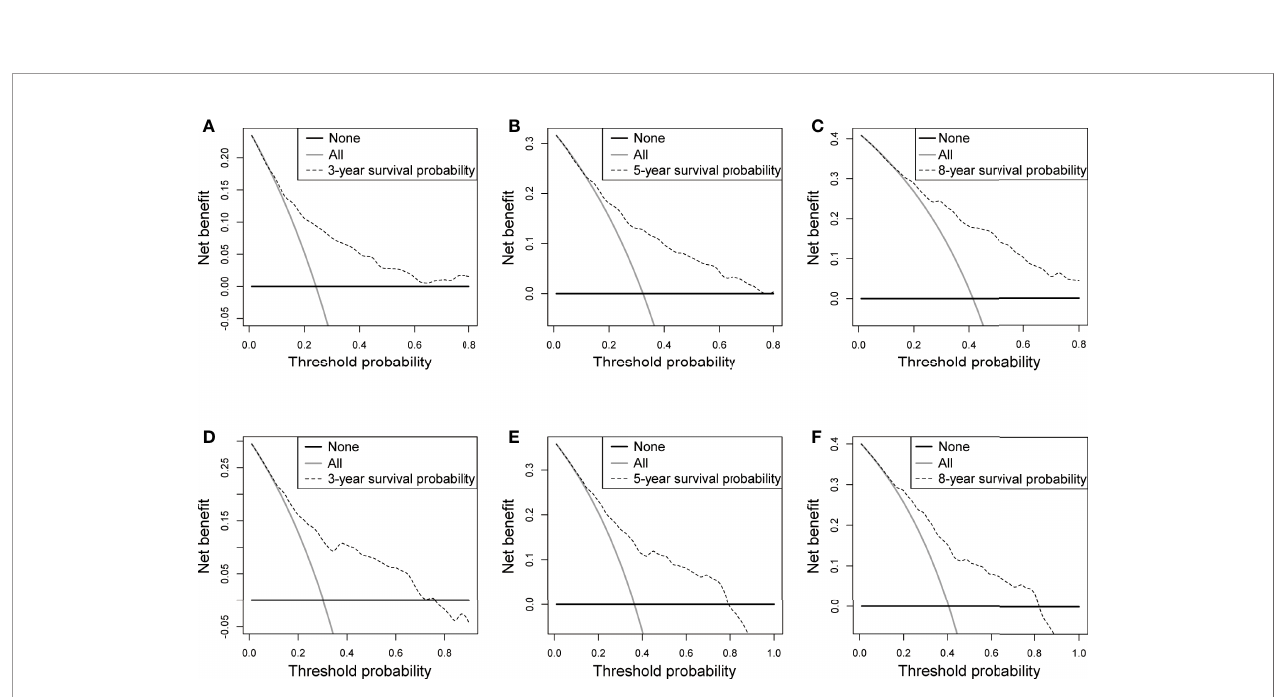
FIGURE 5 | DCA in the training and validation sets. (A-C) 3-, 5-, and 8-year OS rate in the training set, (D-F) 3-, 5-, and 8-year OS rate in the validation